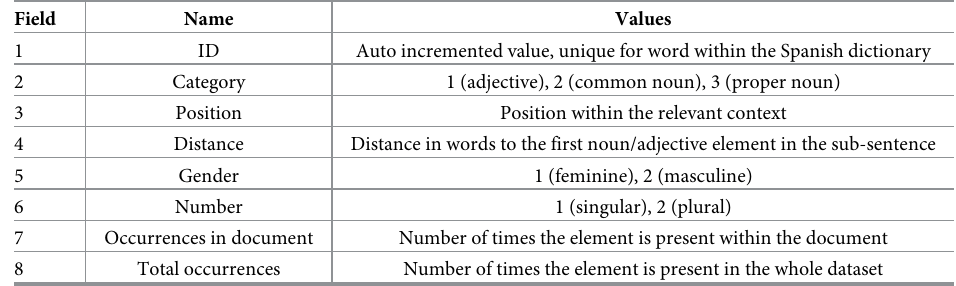
Table 6. Mapping vectors to